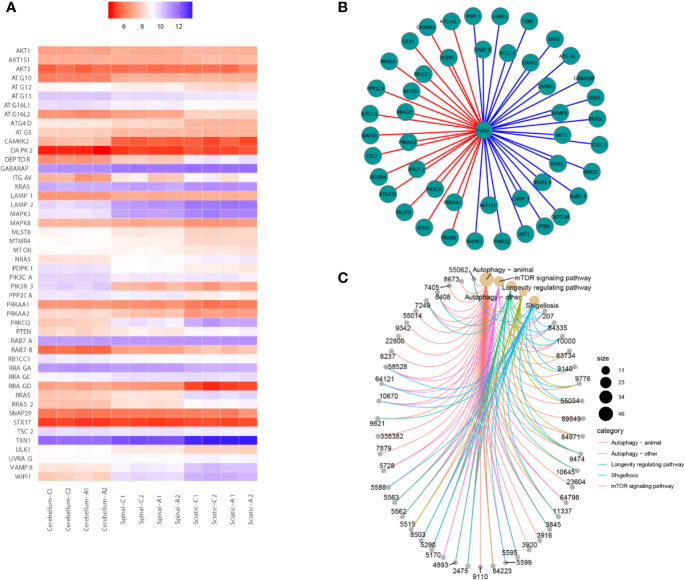
Bioinformatics analysis for gene transcriptional expression. (A) Heatmap showed that the expression of genes correlated with ITGAV in 12 samples. (B) Correlations between ITGAV and genes in the autophagy pathway or genes in the pathway containing TXN1. (C) The genes correlated with ITGAV in the pathway.